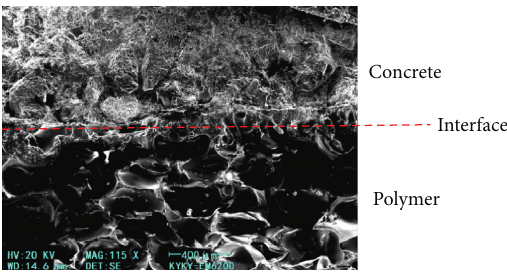
Figure 6: SEM micrograph of microstructure of the